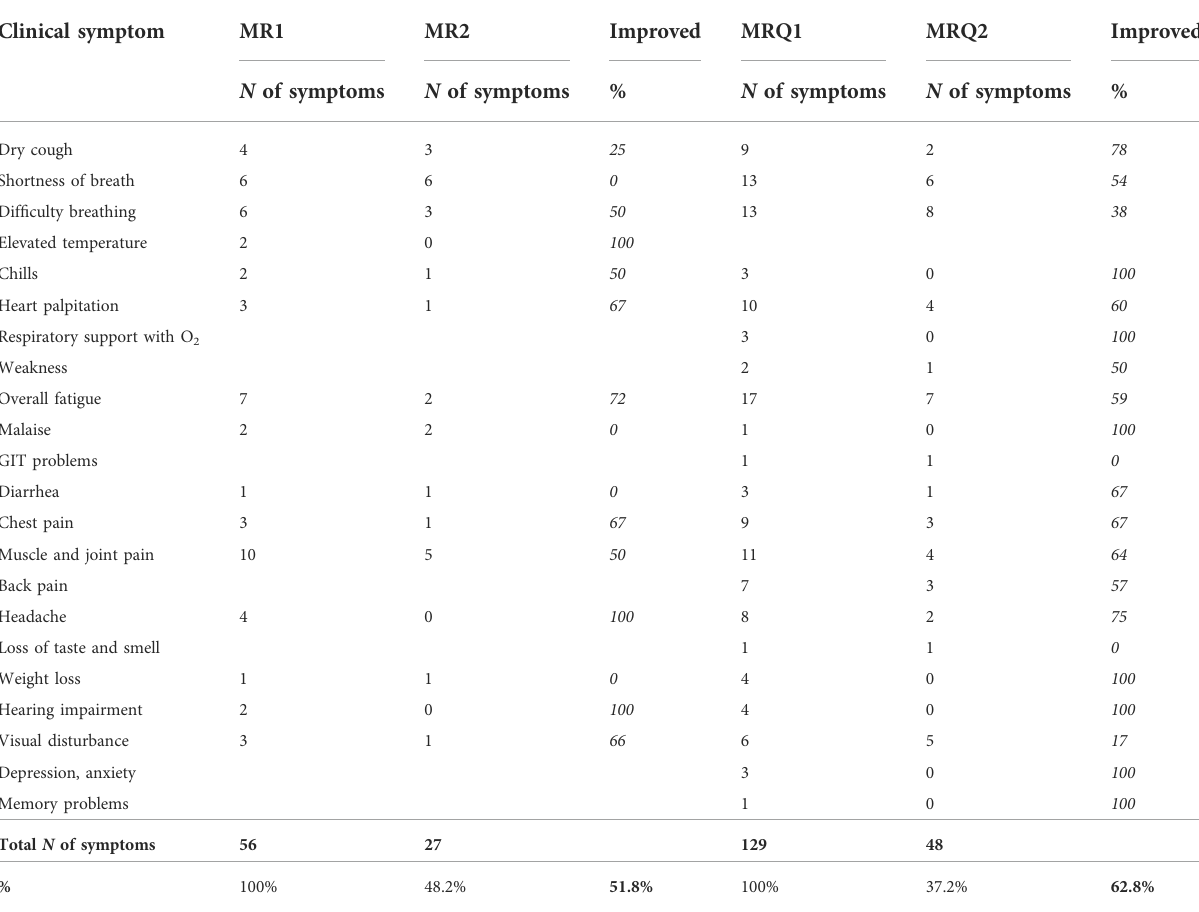
TABLE 2 Effect of rehabilitation program on clinical symptoms of 10 patients with post C-19 from MR group and 20 patients from MRQ group. Clinical